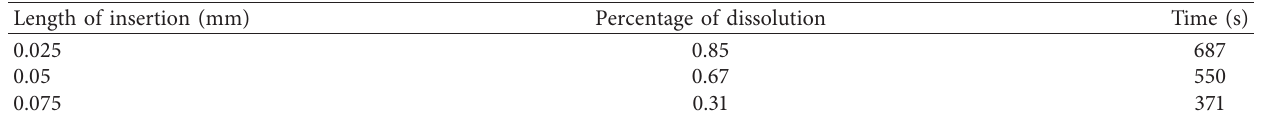
Figure 11: The tPA concentration contours for the thrombolytic process of external position of 0.2mm. The concentration of (a)–(f) changes over time. Blue area means low tPA concentration and red area means high concentration. Table 4: Thrombolytic time of